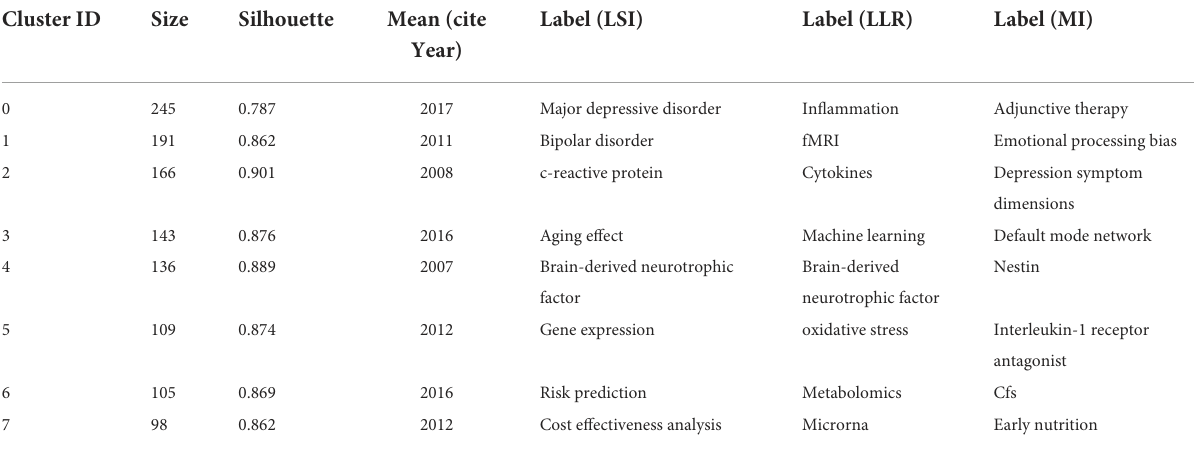
TABLE 5 The largest 8 clusters of depression biomarkers references co-citation, identified by subject